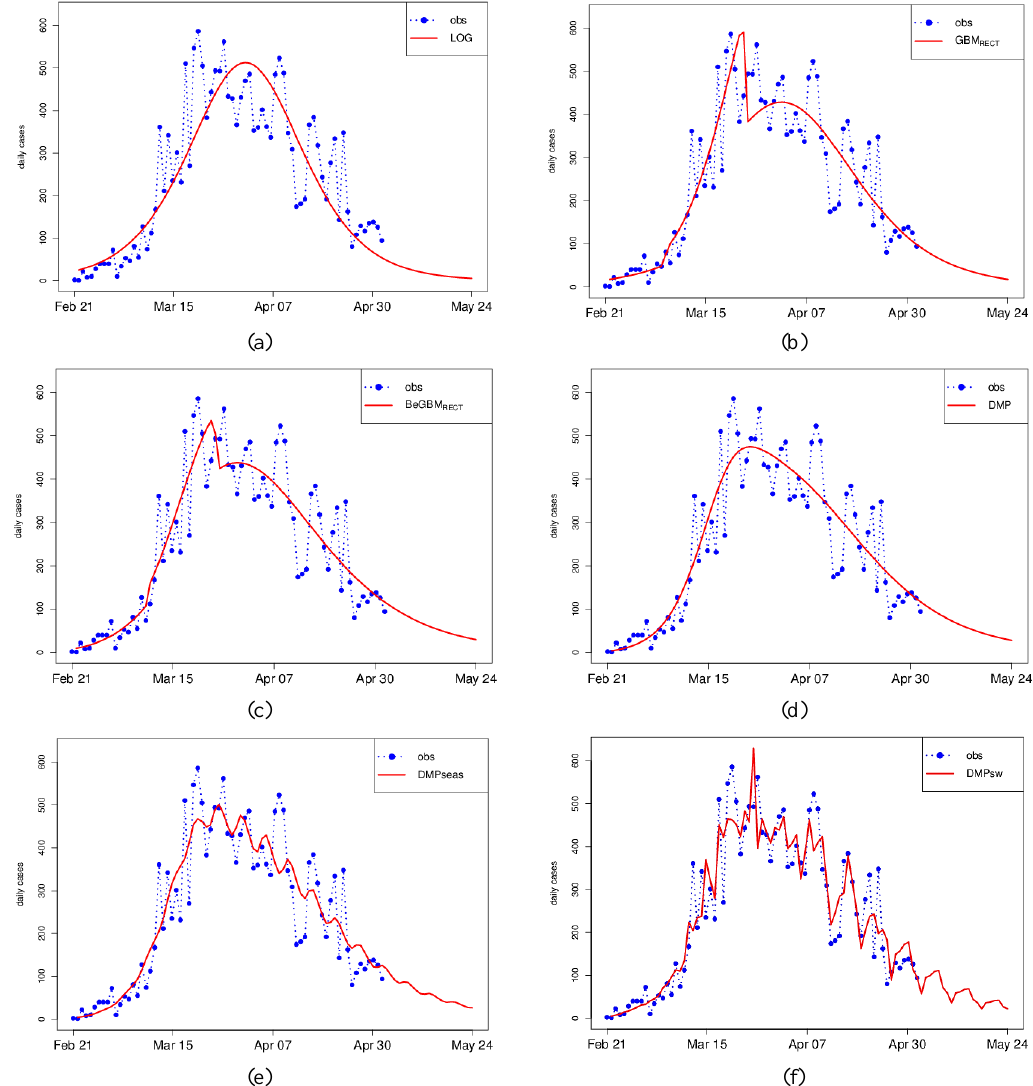
Figure 4. Veneto. Observed and fitted values with the alternative models. (a) Logistic (LOG); (b) GBM with rectangular shock (GBM 𝑹𝑬𝑪𝑻 ); (c) Bemmaor GBM with rectangular shock (BeGBM 𝑹𝑬𝑪𝑻 ); (d) Dynamic market potential (DMP); (e) Dynamic market potential+seasonal effect (DMPseas); (f) Dynamic market potential+swabs